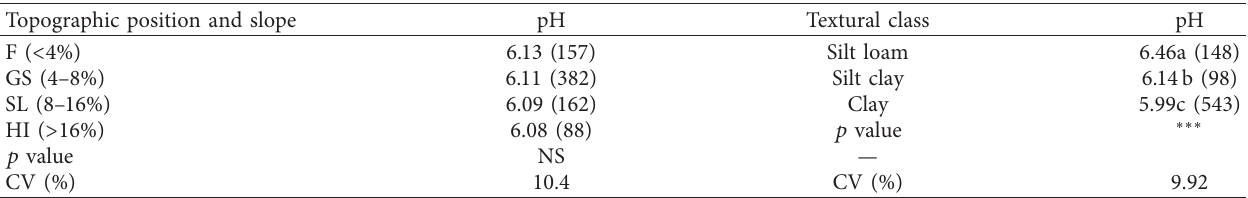
Table 3: Effects of topographic position and soil texture on the mean value of soil pH ( n � 789). Topographic position and slope